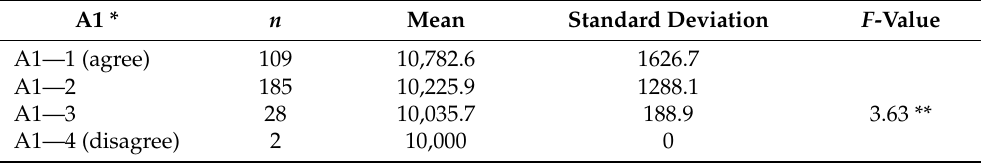
Table 5. Results of One-way ANOVA (WTP of Q type 1).